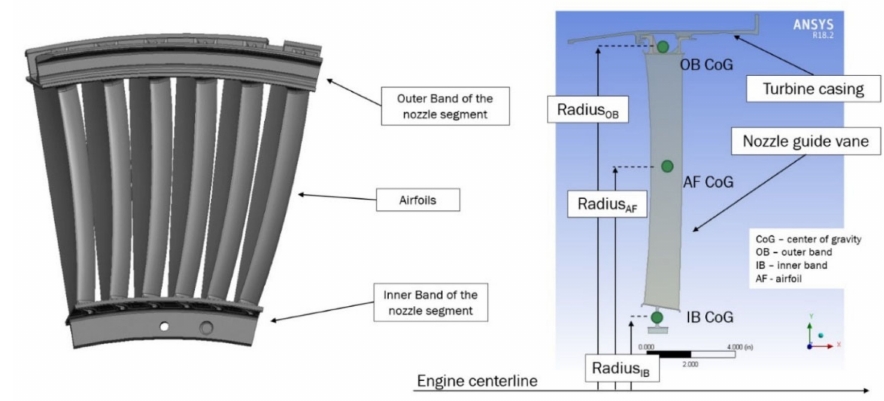
Figure 10. Approach for two-dimensional analysis.